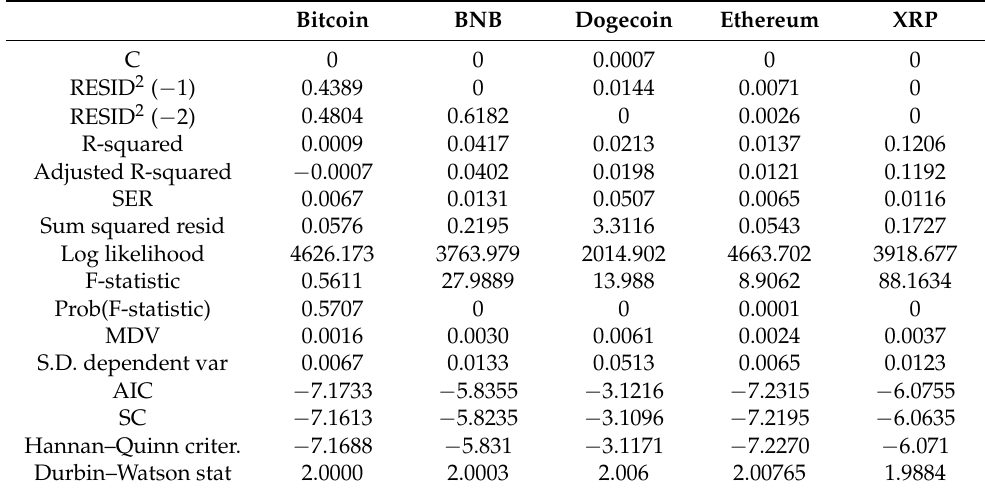
Table 5. Heteroskedasticity: Regression Statistics of Return.